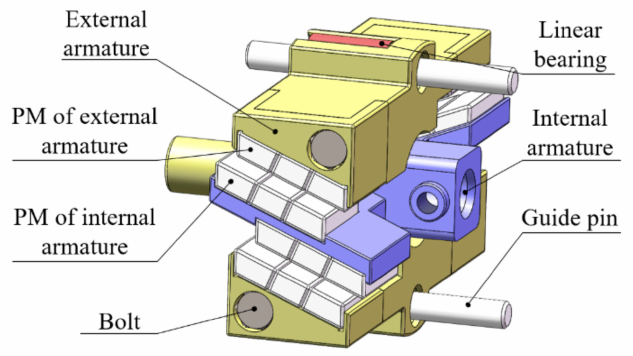
Figure 1. Schematic of maglev coupling.